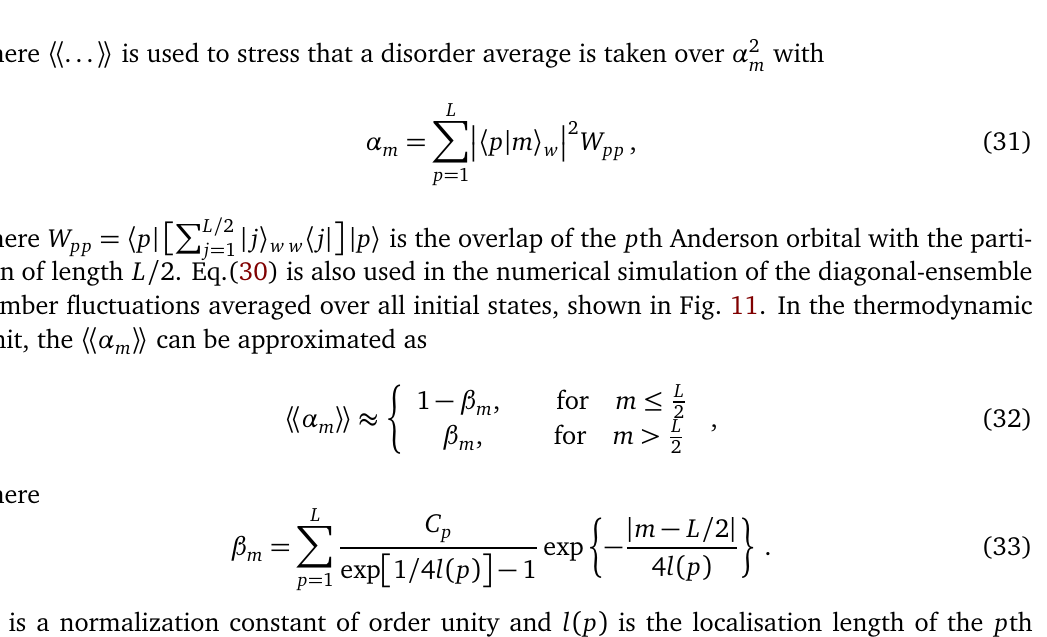
Figure 12: Histogram of particle number fluctuations in eigenstates | α 〉 of the Ander- son model for different system sizes L . One clearly recognizes that eigenstates with large fluctuations become less and less important when increasing the system size. In all plots we have used 5000 disorder